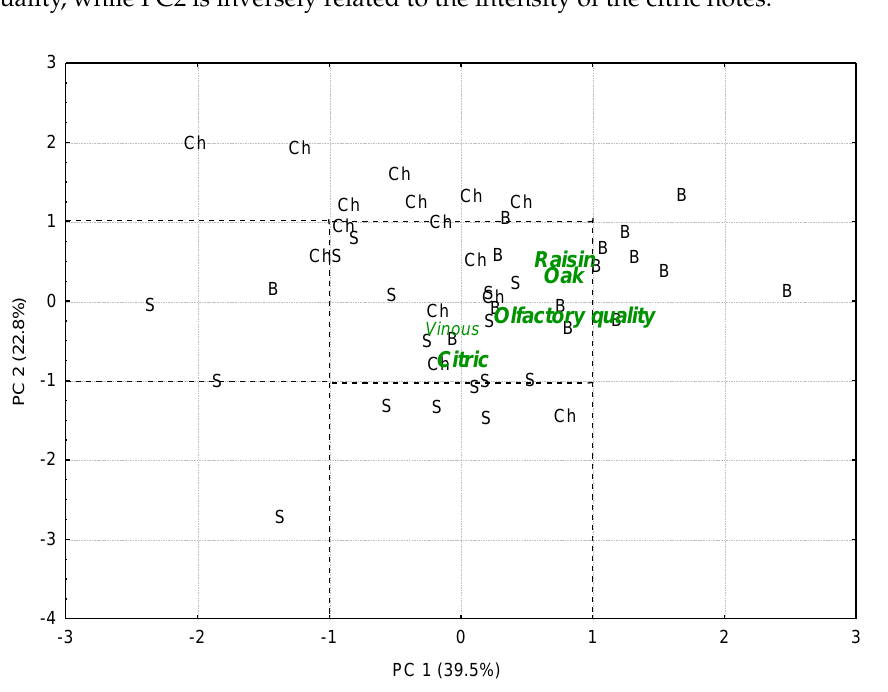
Figure 2. Principal components analysis of the sensory data of the same Muscat wine, vintage 01, aged under 3 different ageing methods (Ch: oak chips; B: oak barrels and S: stainless steel containers). Representation of both, the samples scores and the principal component loadings, onto the plane defined by the first two PCs.